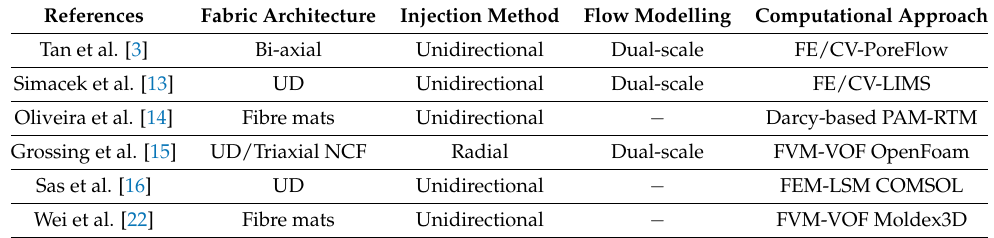
Table 1. Selection of numerical contributions that evaluated simulation tools for flow-front